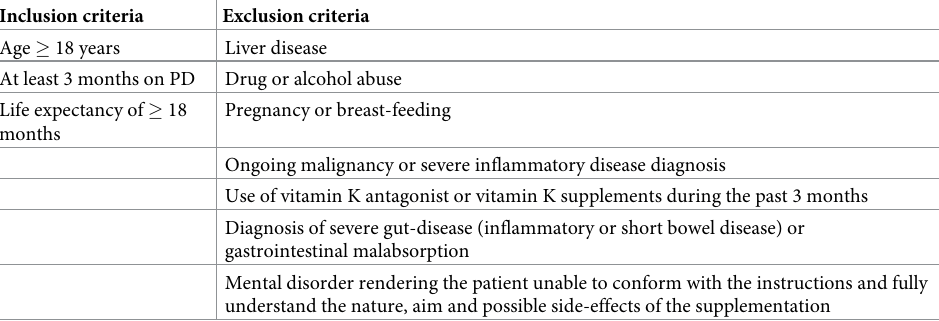
Table 1. Inclusion and exclusion criteria of the VIKIPEDIA